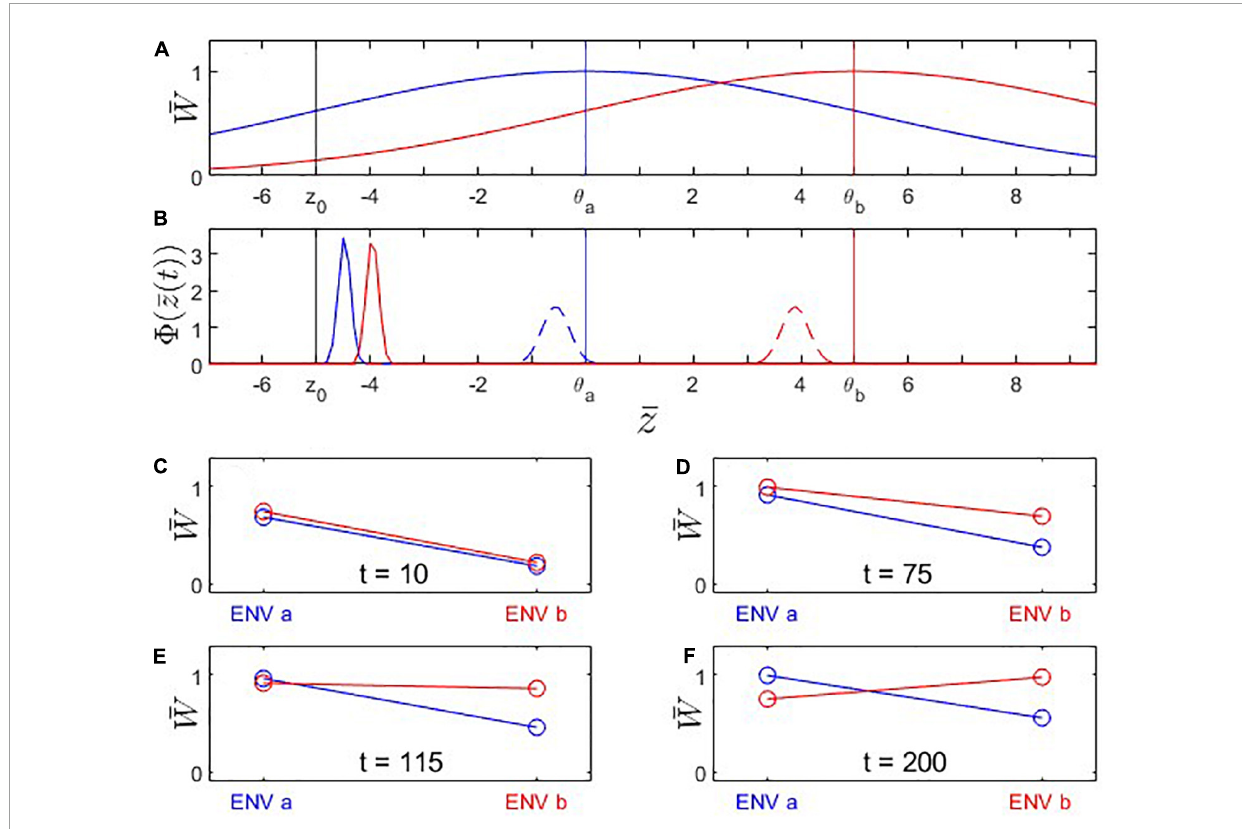
FIGURE3 Fitness landscapes, trait evolution and reciprocal transplant experiments under Scenario 2: Trait optima are stationary; initial trait value ¯ z 0 is located at a suboptimal value to the left of the fitness optimum for environment a . Both populations adapt to new environmental conditions but population B ’s (red) fitness optimum is farther to the right than population A ’s (blue). (A) Fitness landscapes for population A (blue) and population B (red); vertical lines: fitness optima (blue, red) and initial trait value ¯ z 0 (black). (B) Distributions of phenotypic mean after t = 10 (solid) and t = 200 (dashed) generations of evolution. Note that population A ’s (blue) mean trait value changes less than population B ’s. (C–F) Fitness plots for hypothetical reciprocal transplant experiments performed at t = 10, 75, 115, 200. Parameters: ¯ z 0 , a = ¯ z 0 , b = − 5; other parameters as in Figure 1